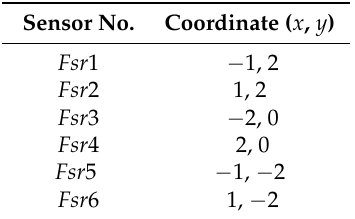
Table 2. The coordinate of each pressure